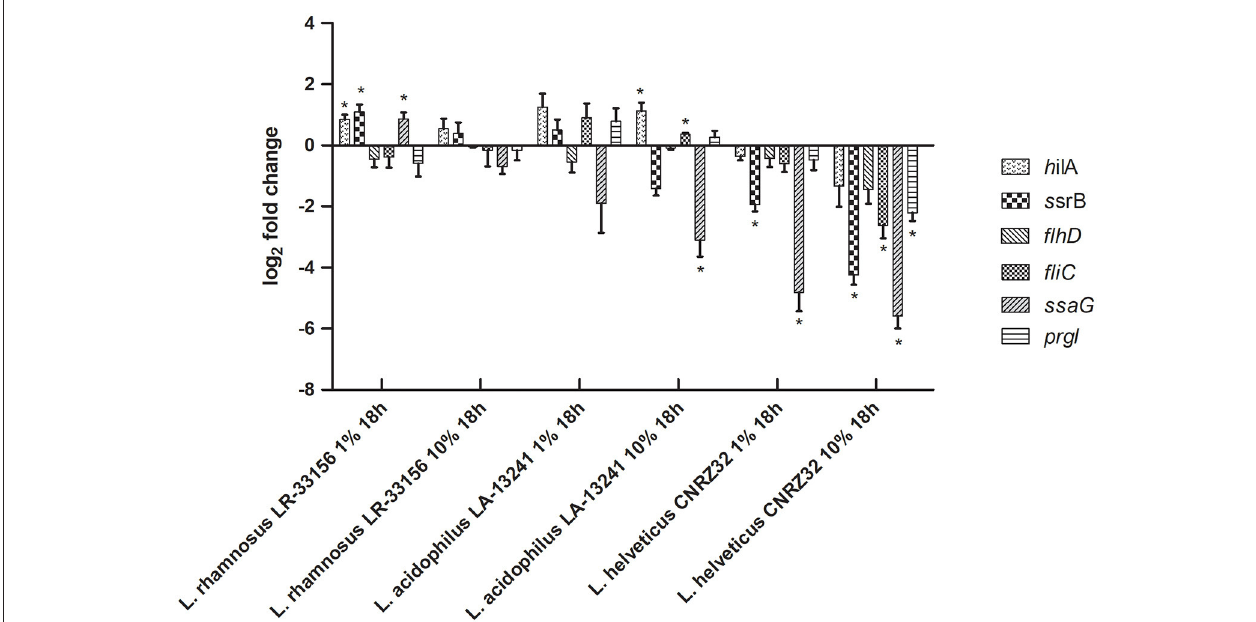
FIGURE 1 | Effect of nCFSM of L. helveticus CNRZ32, L. acidophilus LA-13241 and L. rhamnosus LR-33156 on the expression of hilA , ssrB , flhD , fliC , ssaG and prgI in S . Dublin analyzed by RT-qPCR. The CFSM were prepared from milk fermented 18h with an inoculation level of 1% and 10%. The change in expression of genes is relative to the non-fermented milk control. Three independent replicates including two technical replicates each were performed. The data shown represents the mean and the error bars represent standard deviations. The stars indicate statistical significance at different levels: * P ≤ 0.05.